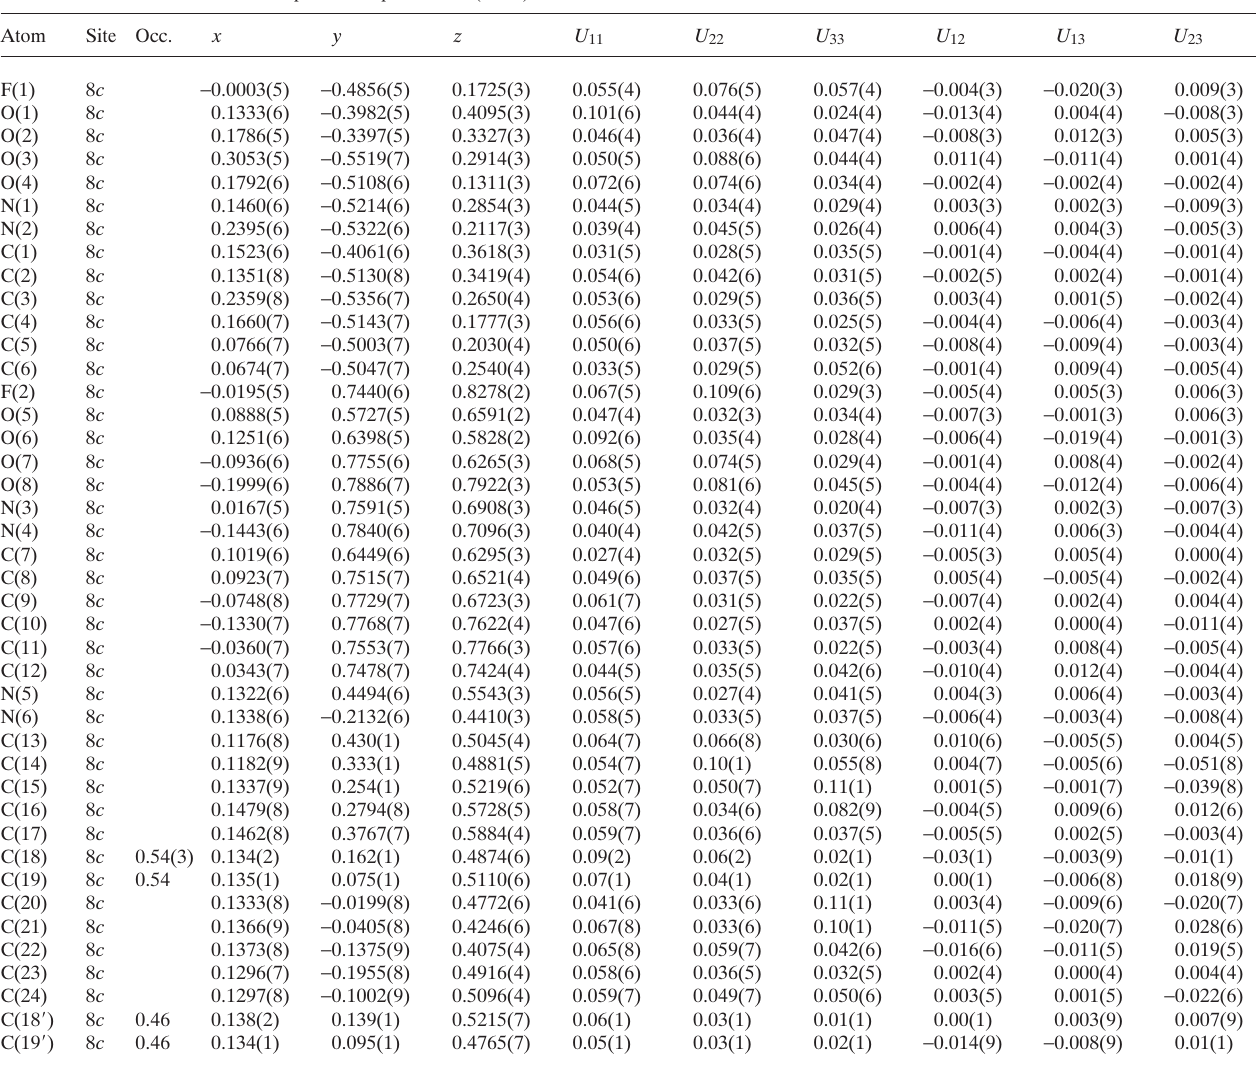
Table 3. Atomic coordinates and displacement parameters (in Å 2 ) . Atom Site Occ.